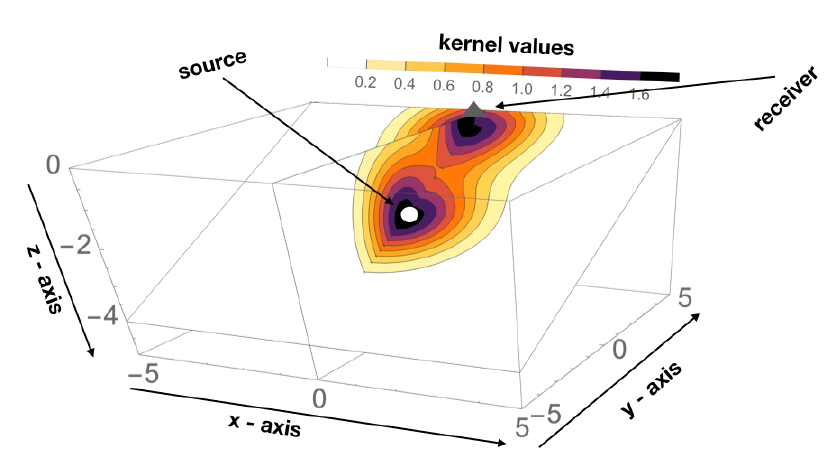
Figure 6. Isolines of the 3D Kernel are depicted in a plane (parallel to x-axis) and in a vertical plane, both cutting source and receiver. Kernel values are normalized at the midpoint between source and